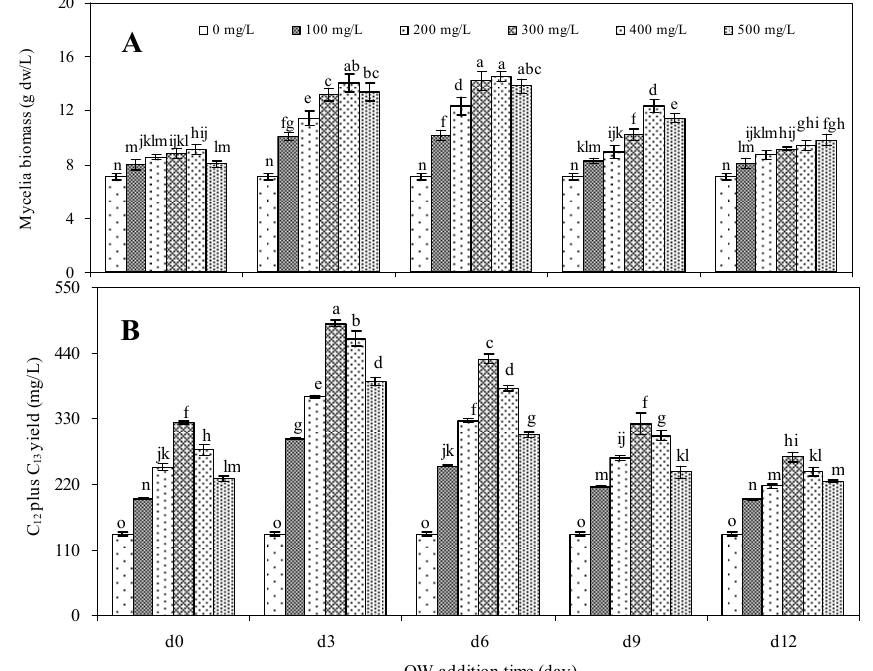
Figure 2. Effects of different concentrations of OW and its addition time on